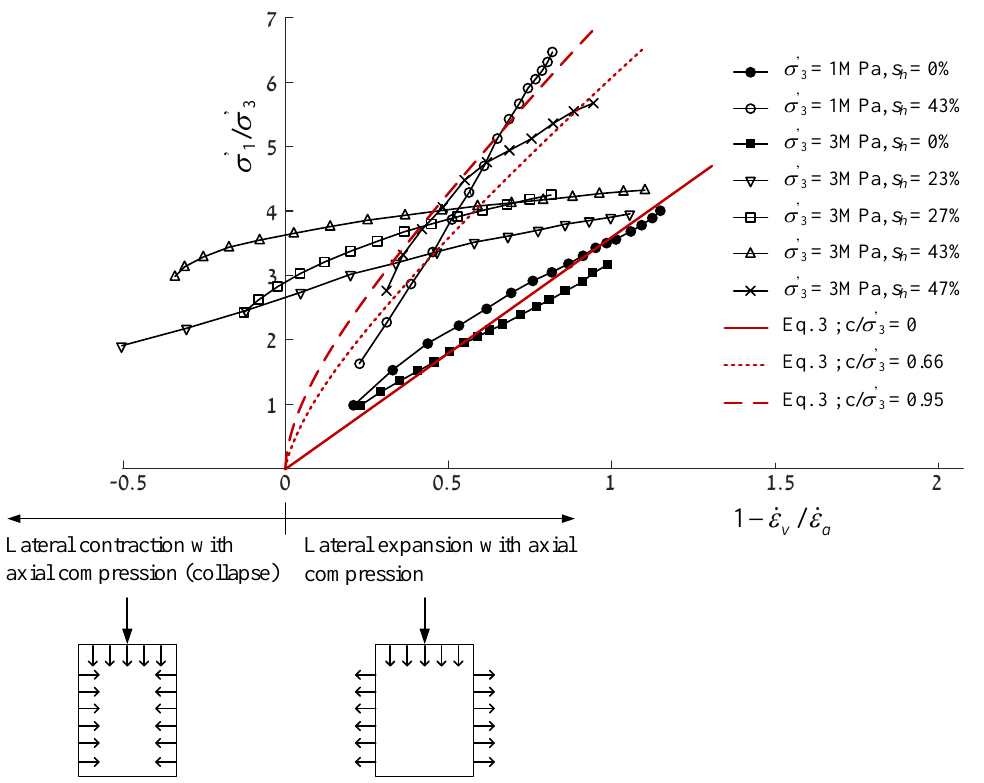
Figure 6. Triaxial test results of gas-saturated MHBS [19], represented on the 1 − ˙ (cid:101) v / ˙ (cid:101) v and σ (cid:48)